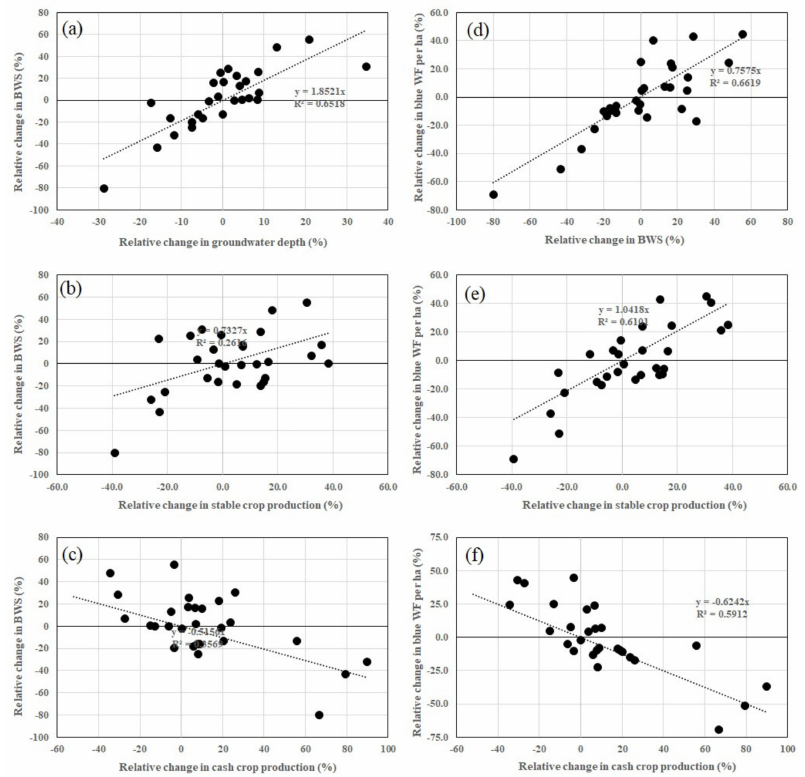
Figure 13. ( a – f ) Synergies/tradeoffs between SDGs indicators in the Khuzestan province over the period 1986–2016. i.e., BWS denotes blue water scarcity, and WF denotes water